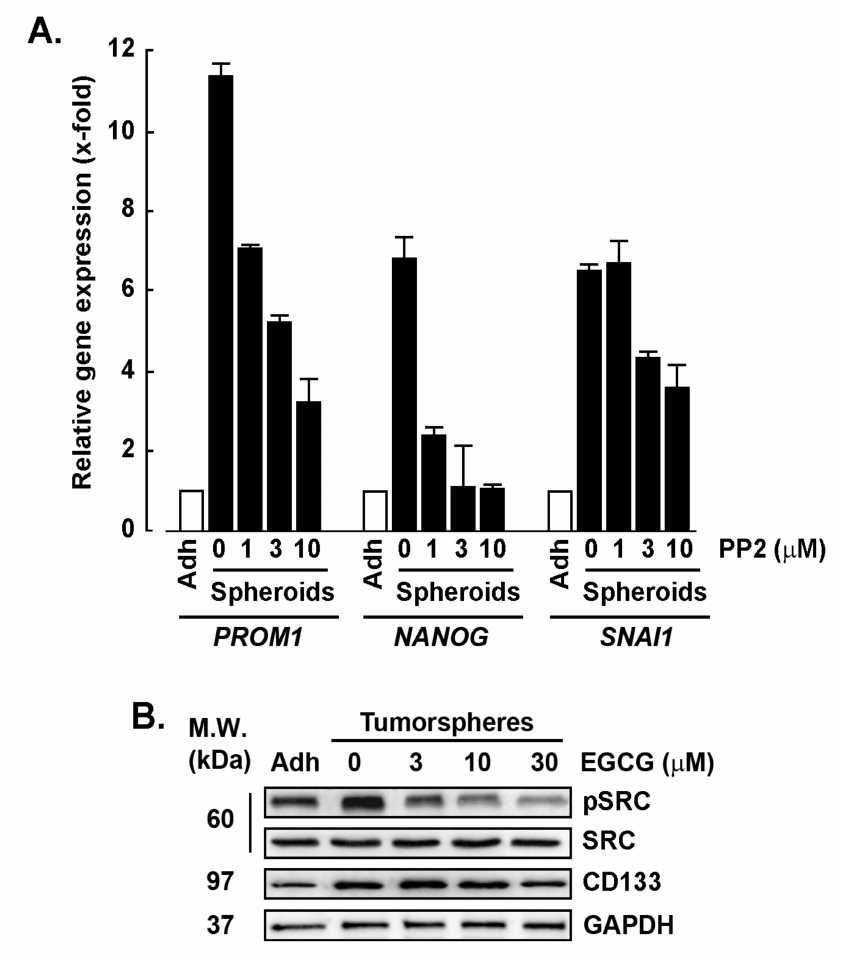
Figure 5. Pharmacological inhibition of the Src signaling pathway alters the acquisition of a stem cell phenotype in ovarian cancer tumorspheres. Tumorspheres were generated from adherent human ES-2 ovarian cancer cell monolayer cultures as described in the Methods section in the absence or presence of ( A ) increasing concentrations of either the Src inhibitor PP2 or ( B ) EGCG. RT-qPCR was